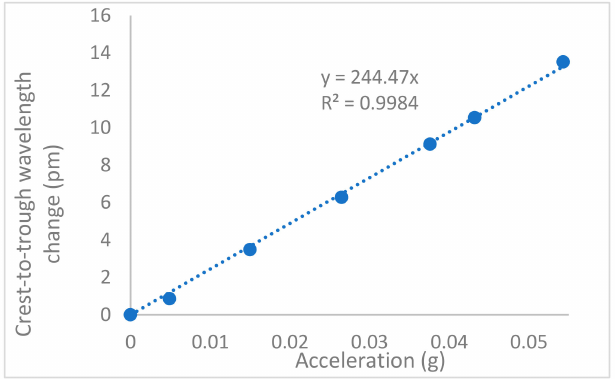
Figure 4. Crest-to-trough sensitivity at 5 Hz.